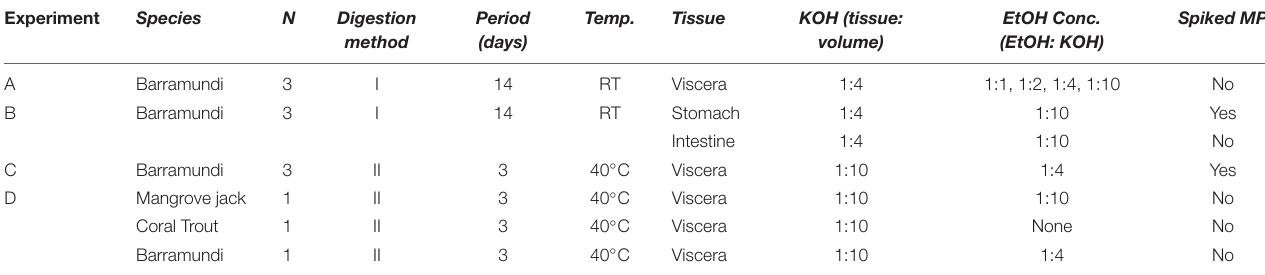
TABLE 1 | Methodological approach used to optimize potassium hydroxide (KOH) digestion of lipid-rich fish tissues and recovery of spiked microplastics. Experiment Species N Digestion